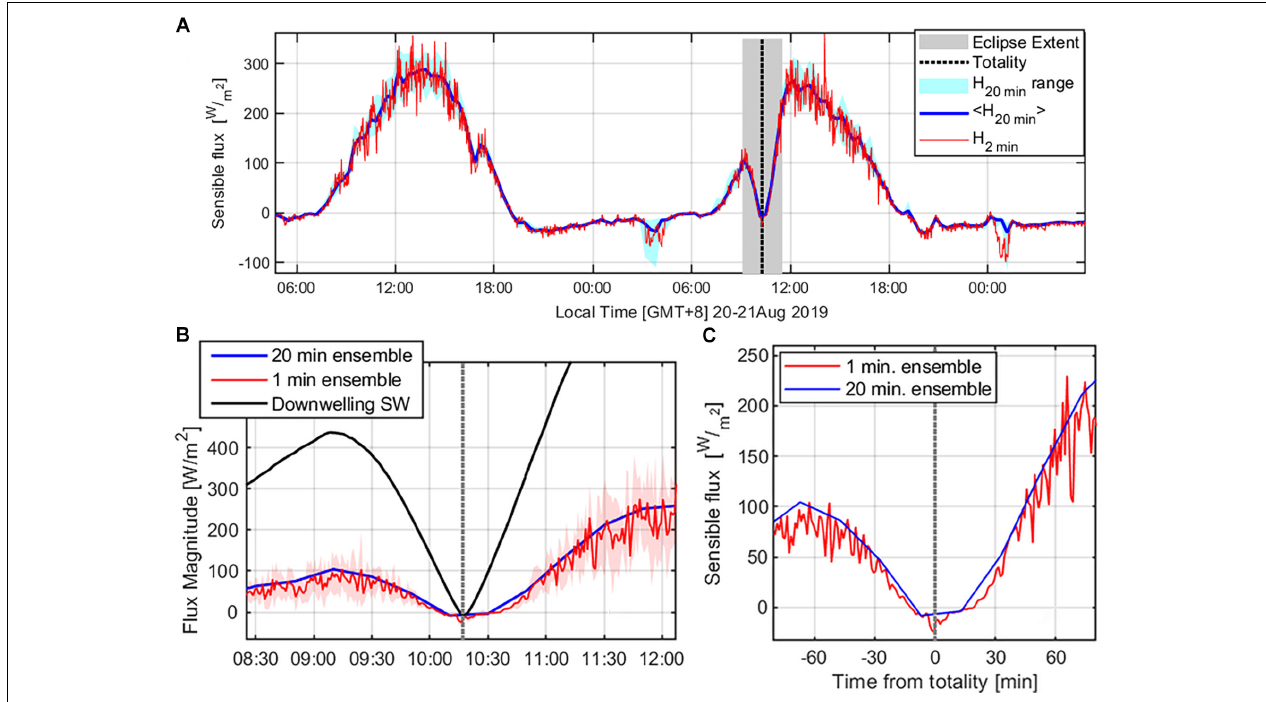
FIGURE 7 | Comparisons between the sensible heat fluxes calculated with the STE averaging over periods of (A) 20 min and 2 min along with the 20-min range from the sonic array; (B) Sensible flux calculated for 20 min and 1 min periods, with ± 1 standard deviations of 1 min flux time series (shaded), and the downwelling shortwave (SW) radiation; and (C) 20 min and 1 min sensible flux at 2 h period centered on totality.